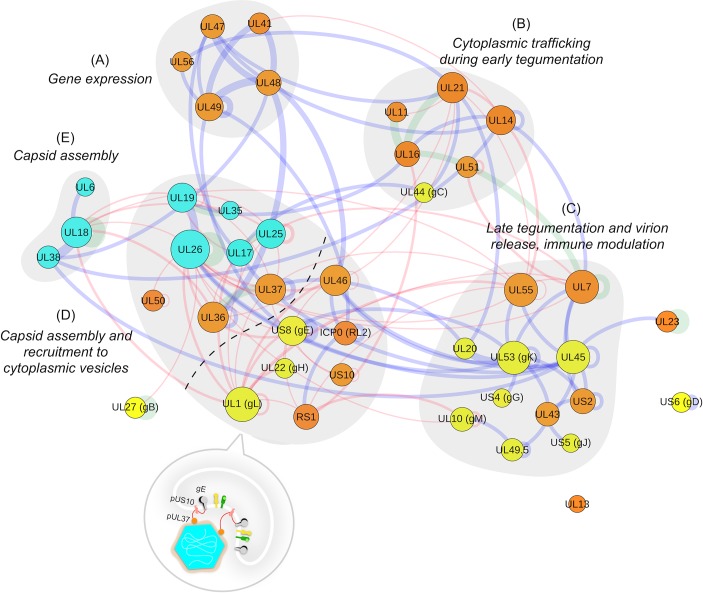
Community structure inferred for the HSV1 virion network.Different communities are delineated by grey areas and labels. Nodes and edges colour-coding follows the same criteria as described in Fig 2, i.e., blue for experimentally supported interactions, red for computationally predicted, and green for interactions with both experimental and computational supporting evidence. The dashed line in community D indicates the two subsets of proteins observed in the community (see text). The associated pictogram reflects the physical and functional relationships among pUS10, pUL37, and gE in the context of the community. gB, glycoprotein B; gC, glycoprotein C; gD, glycoprotein D; gE, glycoprotein E; gG, glycoprotein G; gH, glycoprotein H; gK, glycoprotein K; gJ, glycoprotein J; gL, glycoprotein L; gM, glycoprotein M; HSV1, herpes simplex virus type 1; ICP, infected cell protein; pUL, protein in unique long region; pUS, protein in unique short region; RL, repeat long; RS, repeat short; UL, unique long region; US, unique short region.